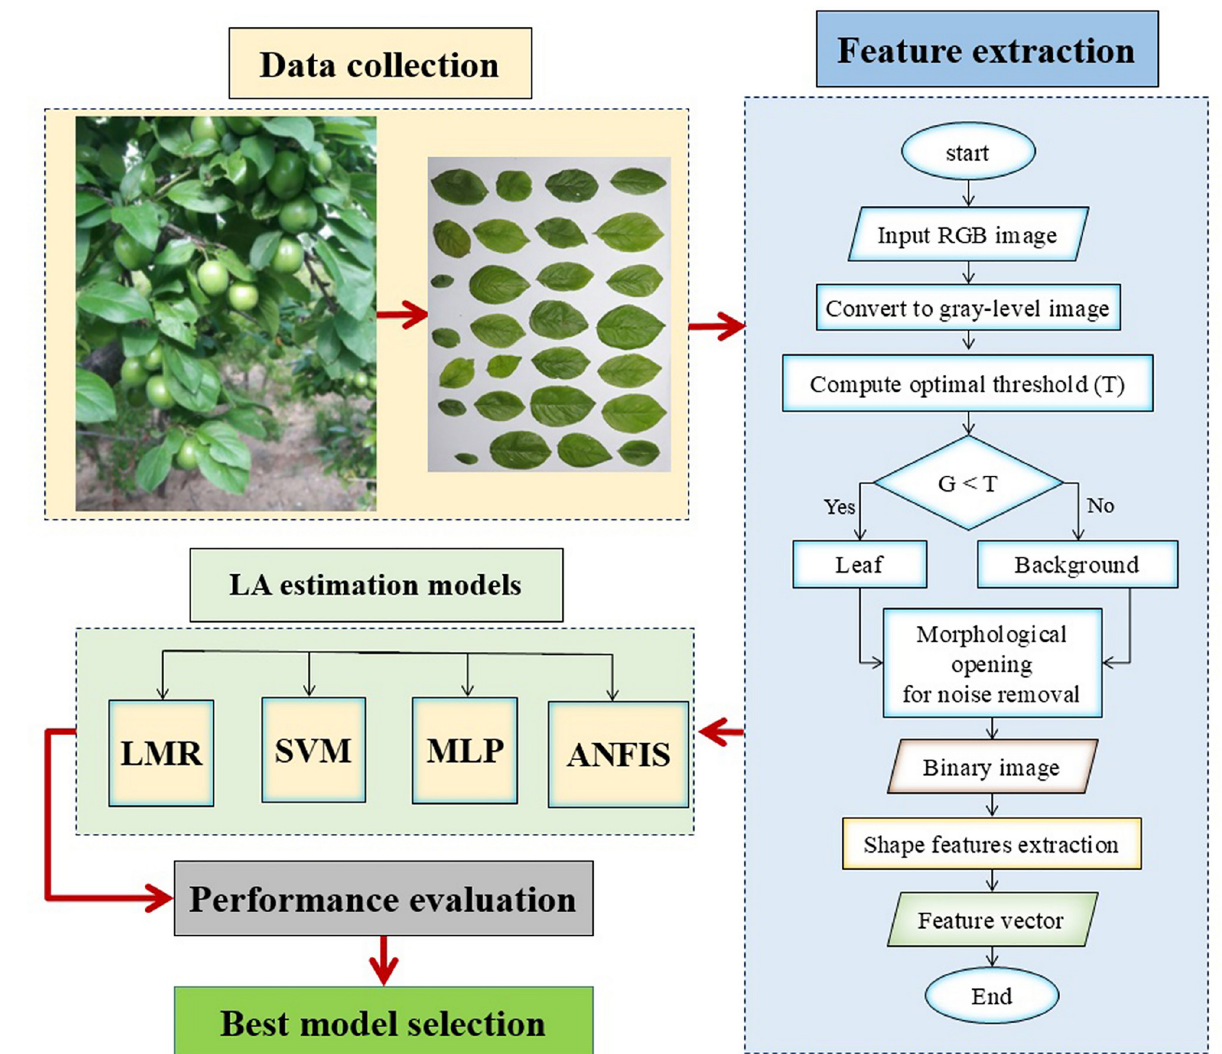
Fig 2. Methodology diagram of the LA estimation model